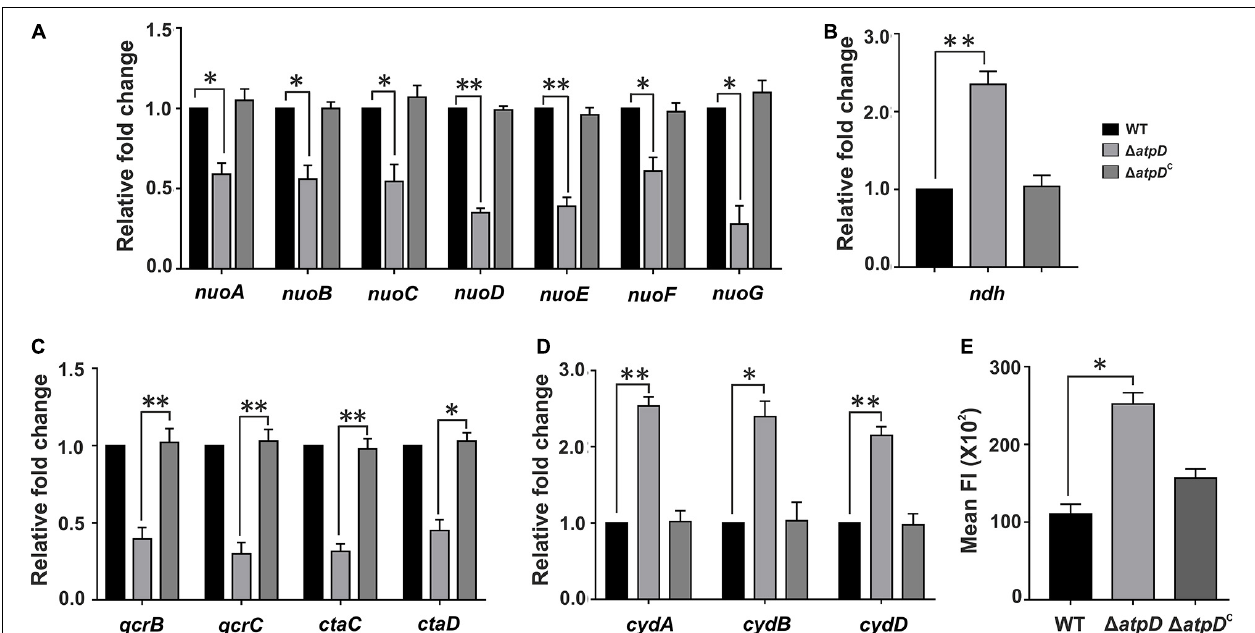
FIGURE 1 | Transcriptional changes in the respiratory chain complexes and an altered membrane polarization in M. smegmatis (cid:49) atpD . Plots show the expression profiles for genes belonging to NDH1 complex ( nuo operon, A ), NDH2 complex ( ndh , B ), cytochrome bc1-aa3 complex ( qcr and cta , C ), and cytochrome- bd oxidase complex ( cyd , D ) in M. smegmatis wild-type (WT), atpD knock out ( (cid:49) atpD ), and atpD -complemented ( (cid:49) atpD C ) strains. Panel (E) shows the membrane polarization in all the three strains as monitored by DiBAC 4 (3) dye. In panels (A–D) , the transcript level in each case is compared with that of M. smegmatis WT, which is taken as 1. In all the panels, data represent an average of at least three independent experiments with error bars representing standard deviation. ∗ P -value < 0.05; ∗∗ P -value <